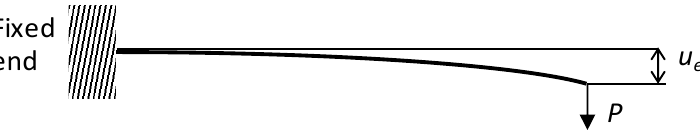
Figure 15. Cantilever stiffness test loading